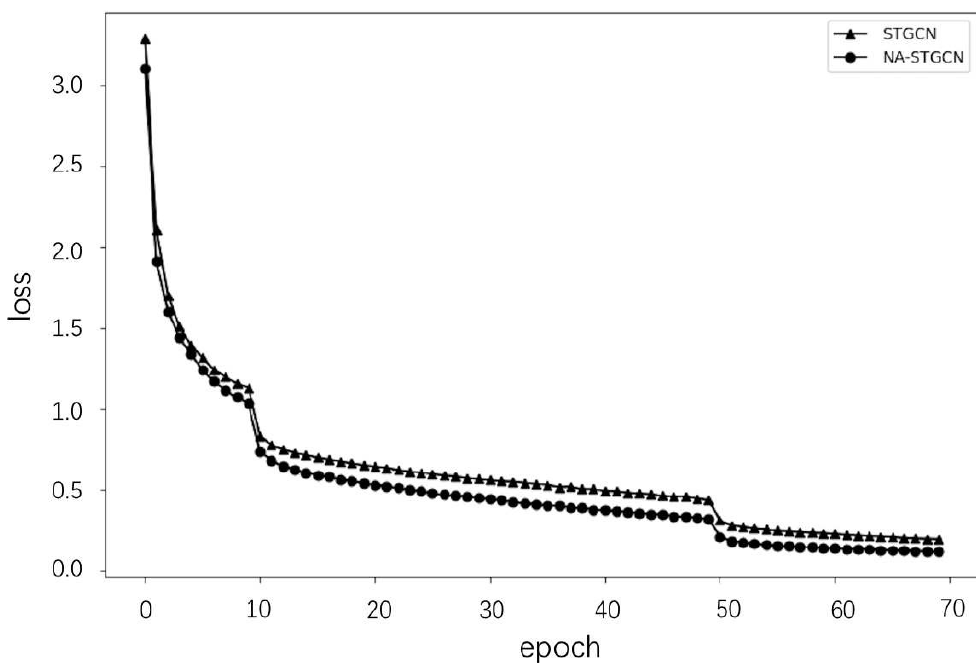
Fig. 3 Change curve of loss values. NA-STGCN, node attention spatial–temporal graph convolutional neural network; ST-GCN, spatial–temporal graph convolutional neural